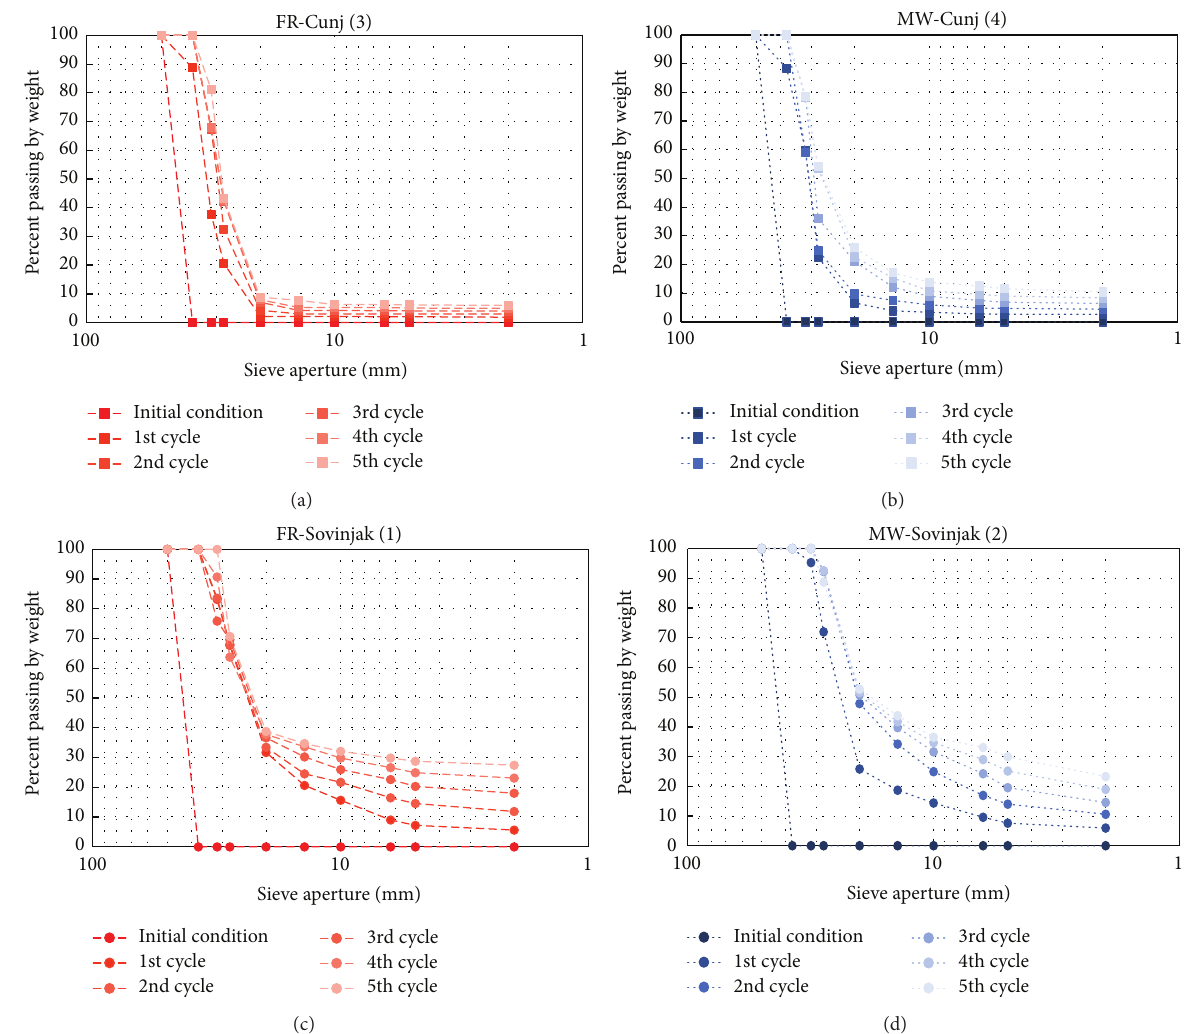
Figure 9: Fragment size distribution curves of the passed weight for the siltstone samples of weathering grades (a) I (FR) (3) and (b) III (MW) (4) from a flysch outcrop near Cunj Village and samples of weathering grades (c) I (FR) (1) and (d) III (MW) (2) from a flysch outcrop near Sovinjak